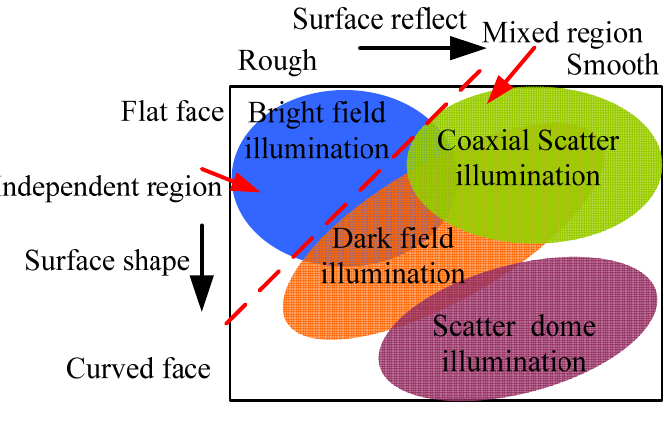
Figure 5. Relationship of light source selection and detected